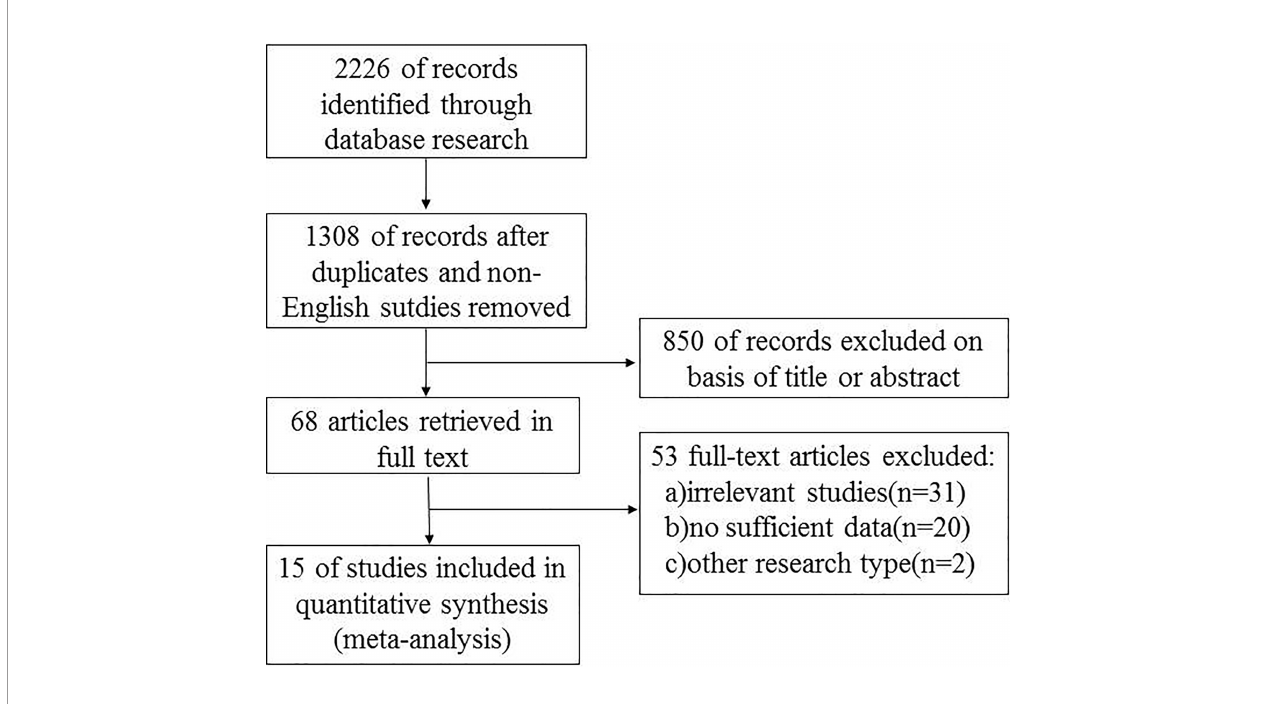
FIGURE 1 | Flowchart of study selection.